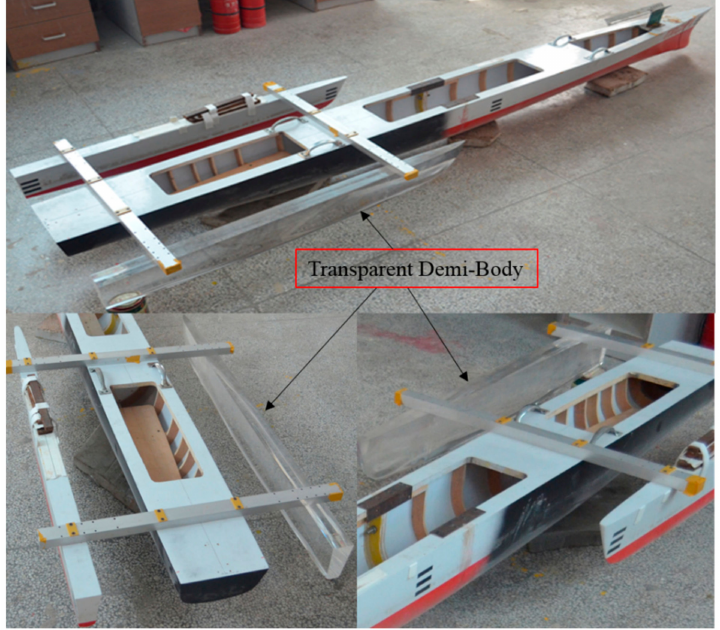
Figure 3. Light trimaran ship model